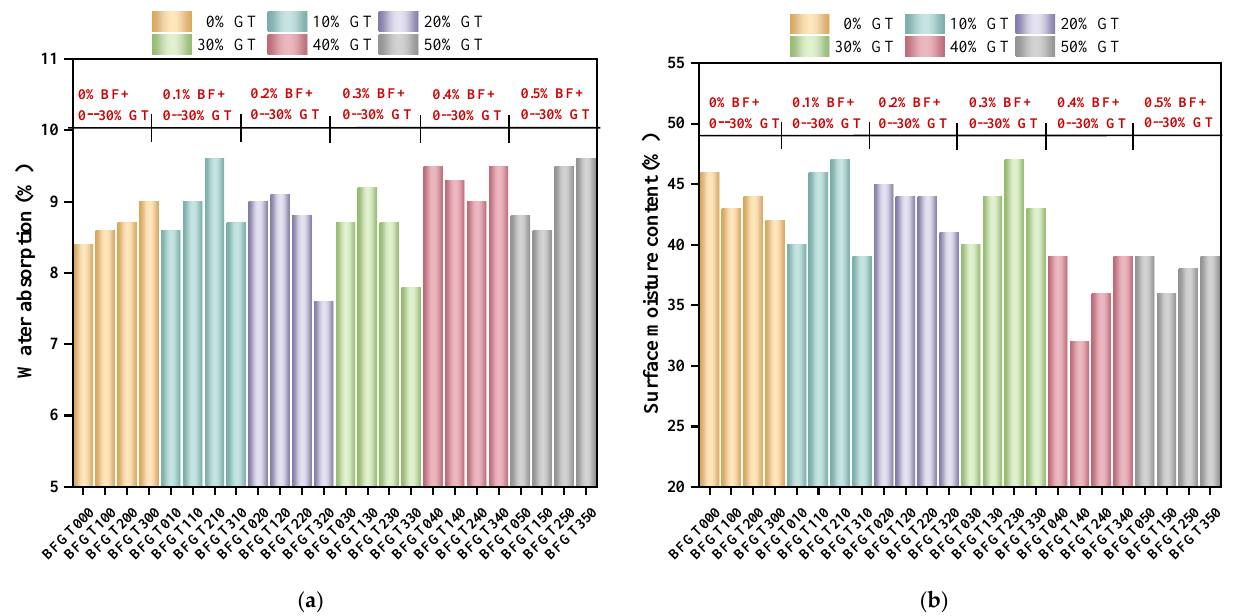
Figure 5. Effect of basalt fibres on Water absorption and surface moisture content of graphite tailings cement mortar. ( a ) water absorption; ( b ) surface moisture content.